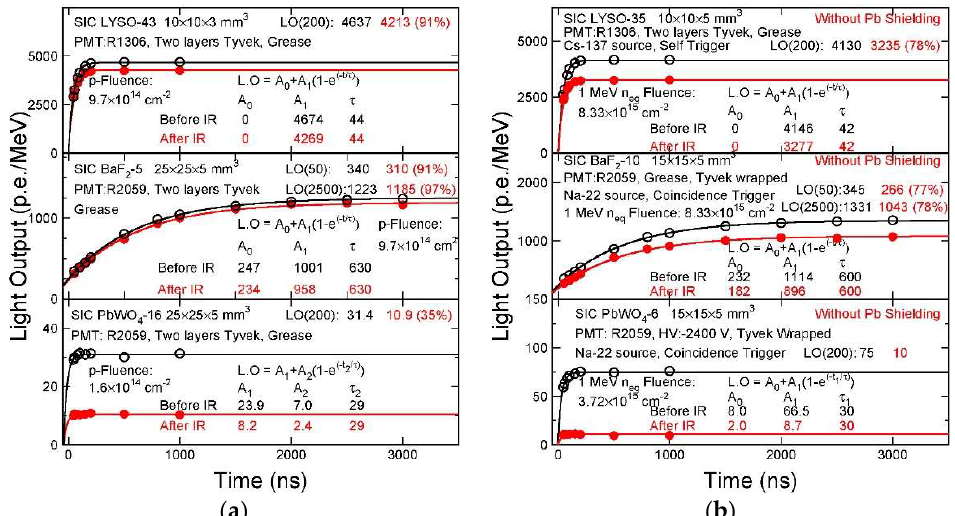
Figure 2. LO measured before (black) and after (red) irradiation in ( a ) the proton experiment 7324 and ( b ) the neutron experiment 7332 [31,32] is shown as a function of the integration time for LYSO ( top ), BaF 2 ( middle ), and PWO crystals ( bottom ).